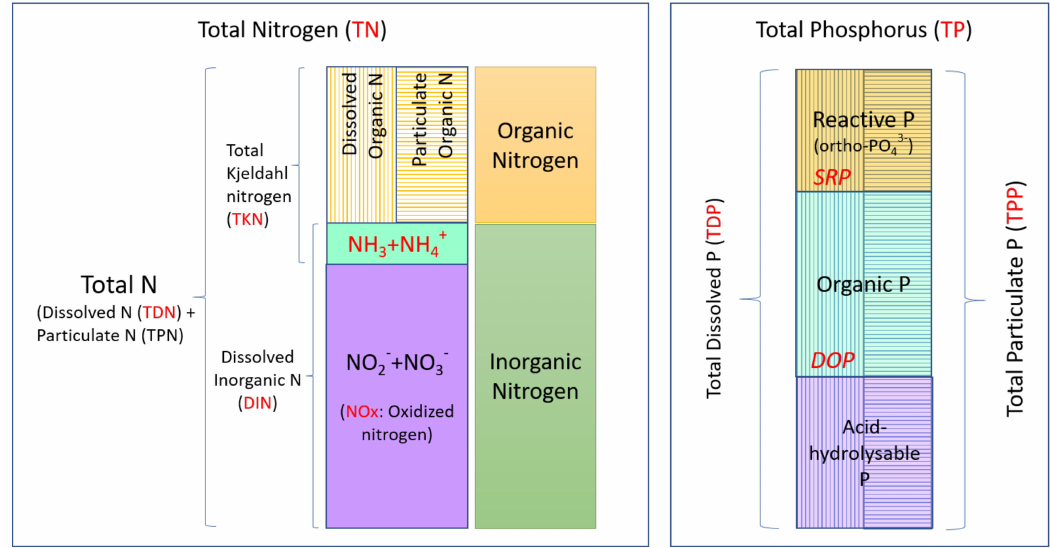
Figure 1. Nitrogen and phosphorus fractions in water. TN and TP fractions are mainly classified as dissolved and particulate and further classified as organic and inorganic. Vertical lines represent the dissolved fractions and horizontal lines represent the particulate fractions of N and P. The fractions monitored in this study are indicated in